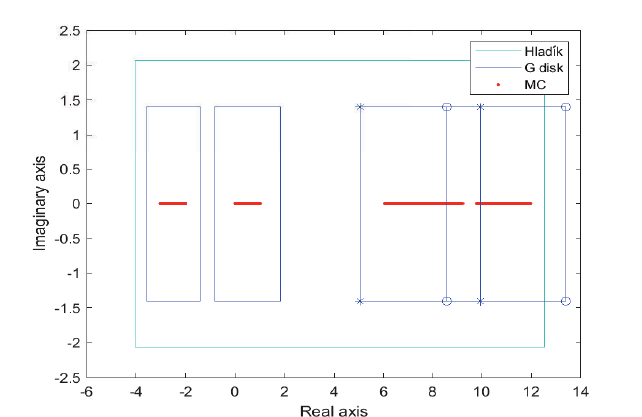
Fig. 4. Eigenvalue set and enclosures of Example